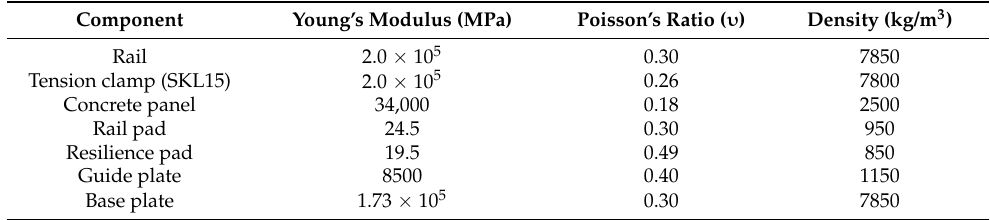
Table 3. Material properties of the tension clamp (38Si7).